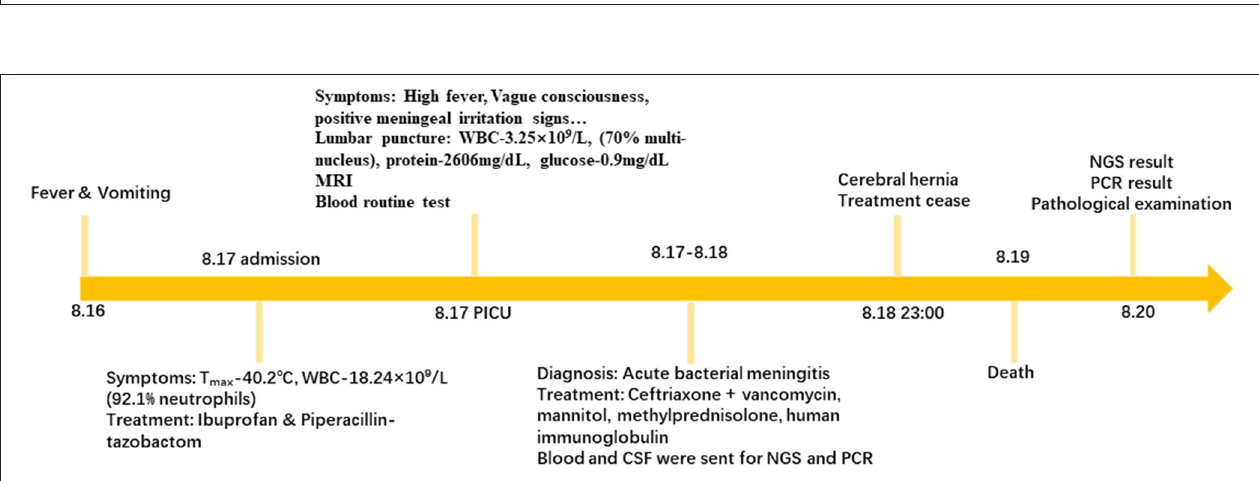
FIGURE 2 | A timeline exhibits the relevant data from the episode of